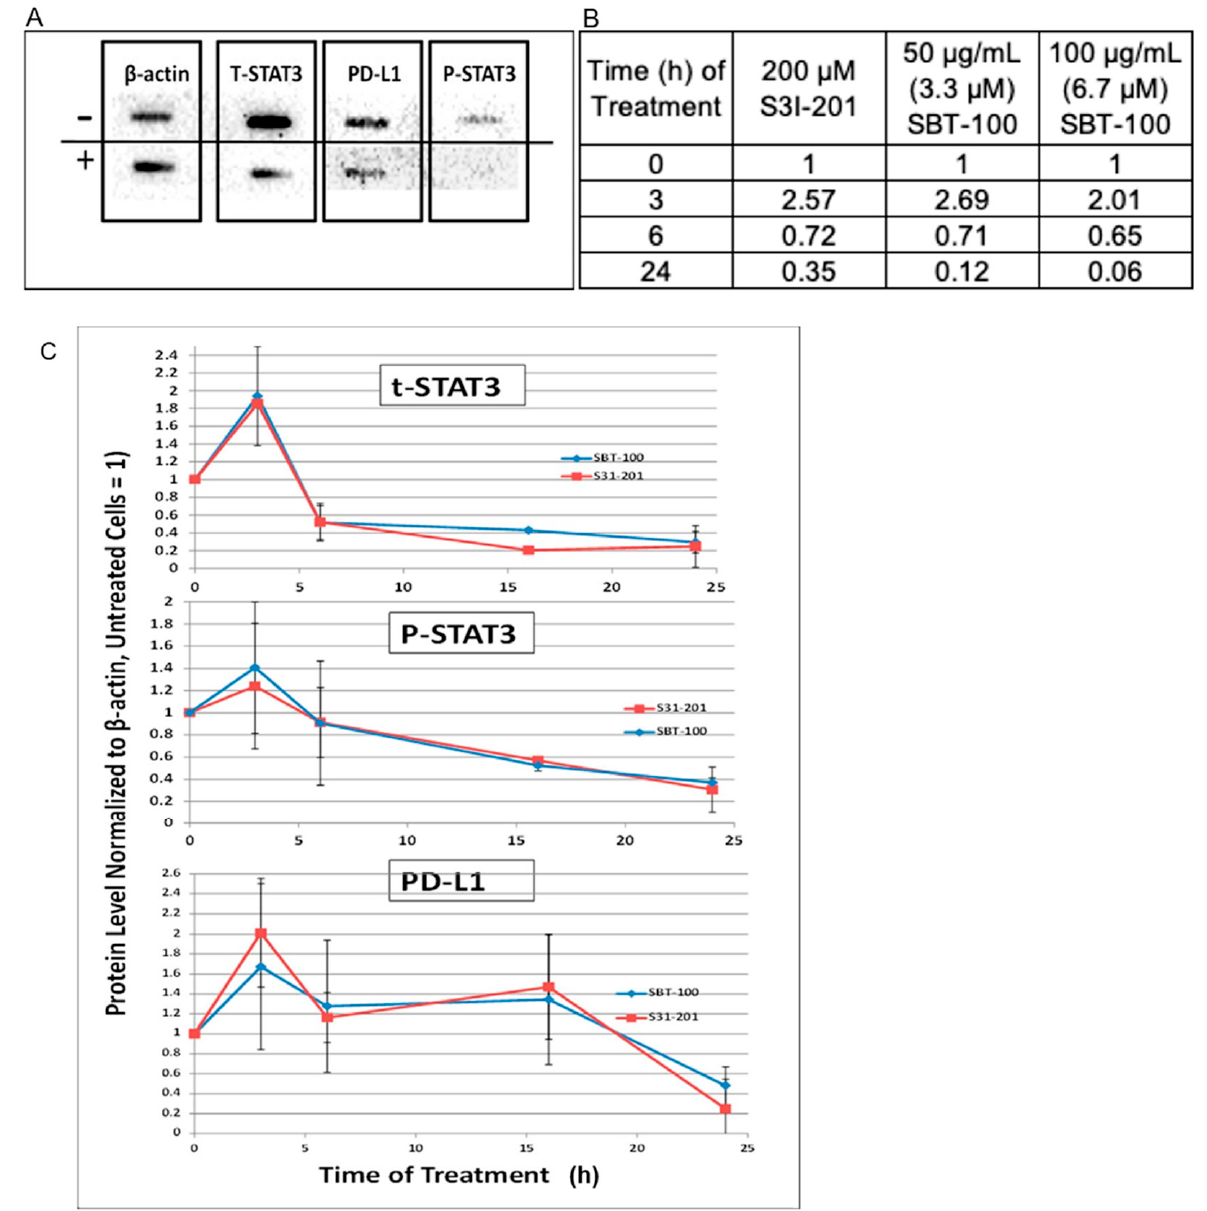
Figure 4. SBT-100 reduces pSTAT3, tSTAT3, and PD-L1 levels in total cell lysate. ( A ) Representative image of immunoblotting of MDA-MB-231 protein extracts for pSTAT3, tSTAT3, and PD-L1 with (+) and without ( − ) SBT-100 at 24 h. ( B ) Quantification of immunoblotting from MDA-MB-231 cells for pSTAT3, tSTAT3, and PD-L1 with and without SBT-100 treatment over a 24 h time course, using S31-201, a STAT3 inhibitor as a positive control. ( C ) Each data point represents the average ± the standard deviation of the β -actin normalized values from 3–5 independent experiments where MDA-MB-231 cells were treated with four different SBT-100 preparations whose final concentration varied between 50–100 µg/mL.